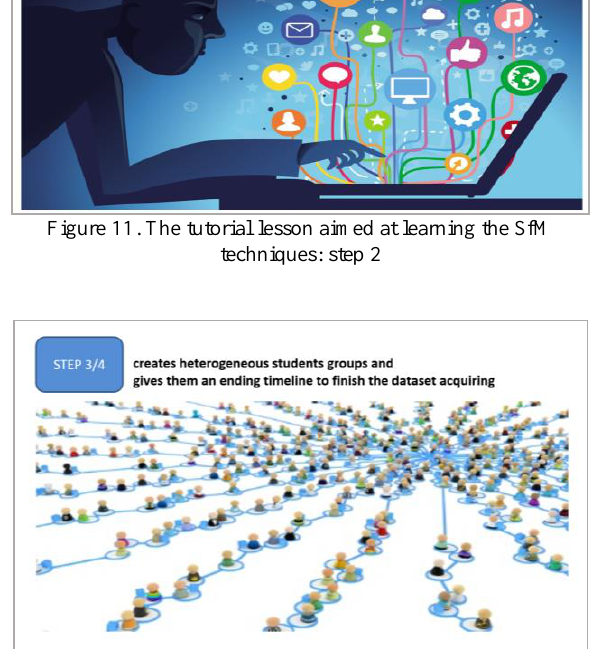
Figure 12. Students groups and timeline: steps 3 and 4